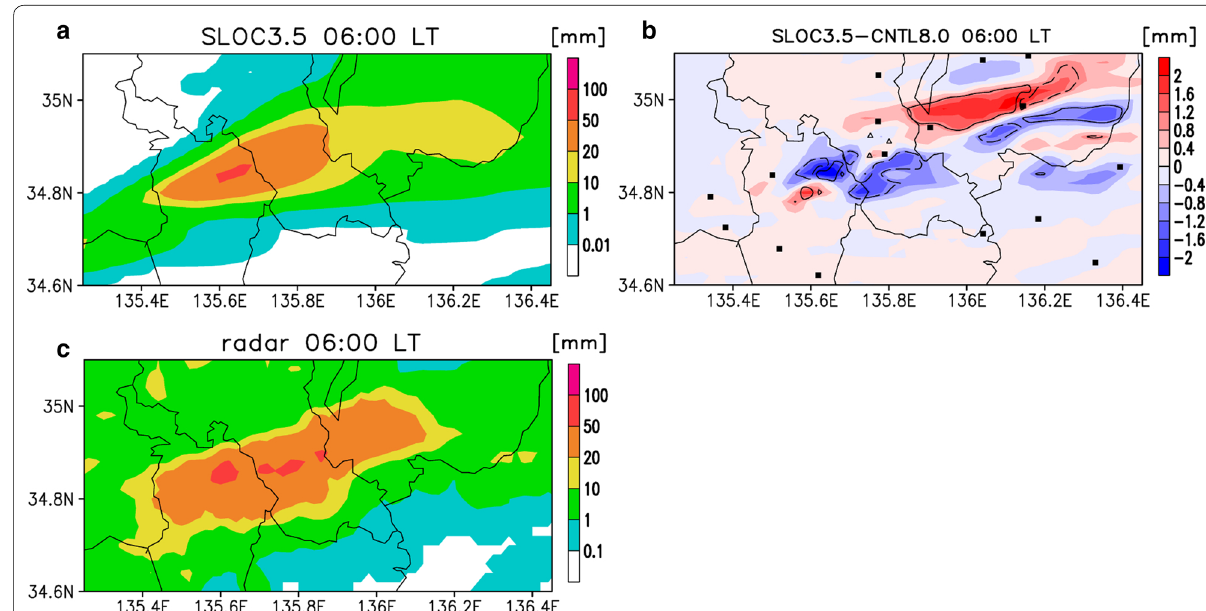
Fig. 13 a Horizontal distributions of 1-h rainfall amount at 0600 LT on August 14, 2012, simulated by SLOC3.5km. b Horizontal distributions of dif- ference of 1-h rainfall amount between SLOC3.5km and CNTL8.0km (shade) at 0600 LT on August 14, 2012. Solid (broken) line indicates that RMSE of 1-h rainfall of the SLOC3.5km is 1 mm smaller (larger) than that of CNTL8.0km. Open triangles and black squares indicate GNSS stations used in SLOC3.5km of the Uji network and GEONET, respectively. c Horizontal distributions of 1-h rainfall amount at 0600 LT on August 14, 2012, observed by JMA weather